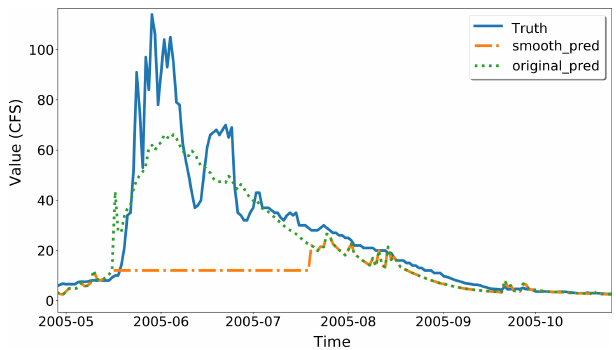
Figure 9. Use 10 as a threshold: there is a plateau around 2005 June generated. CFS is short for cubic feet per